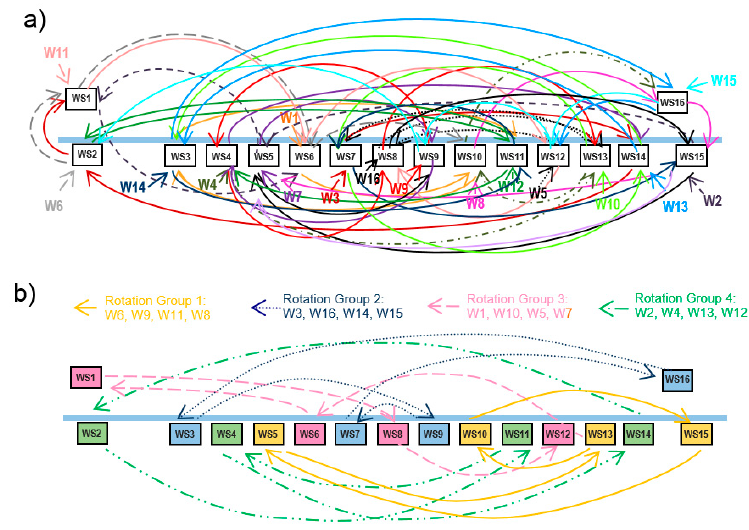
Figure 5. Paths of the workers in the solutions provided by the algorithms ( a ) RGAm and ( b )